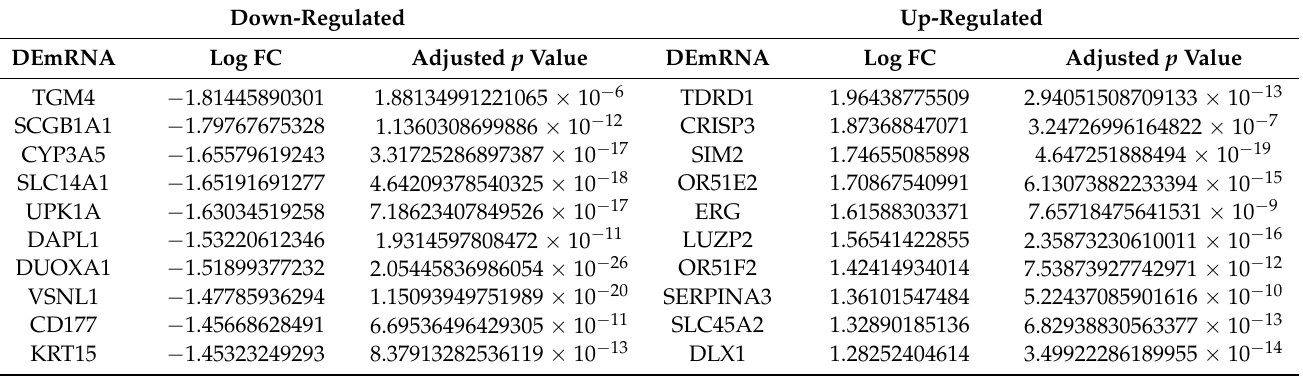
Table 2. The top 10 up- and down-regulated DEmRNAs between prostate and normal samples.